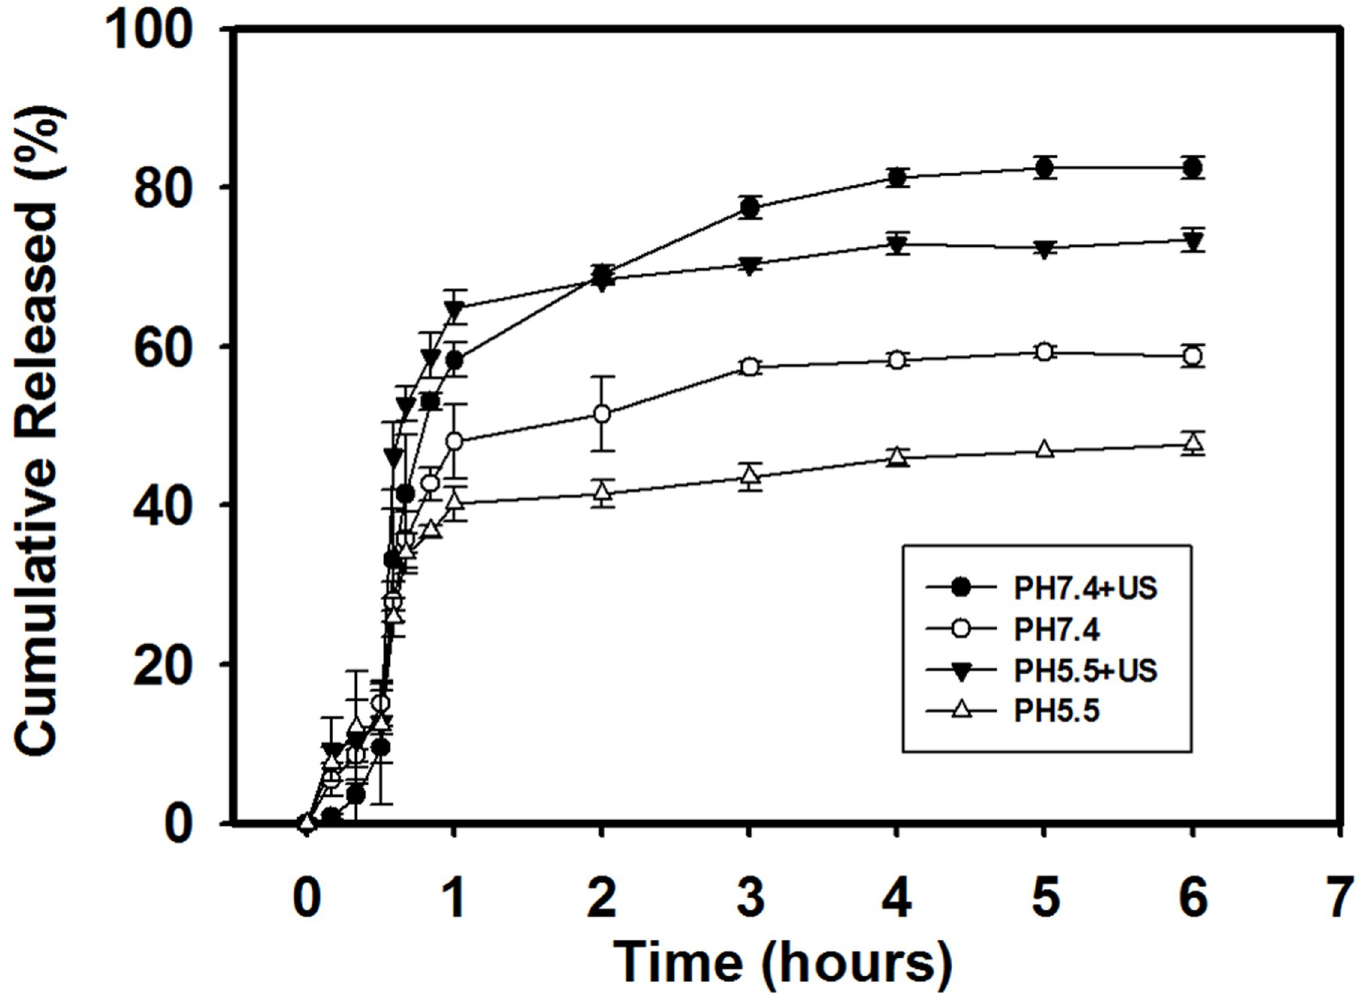
Fig 6. Cumulative Ada release from Ada-LysMBs after 6 h with and without ultrasound sonication in PBS at the indicated pH.